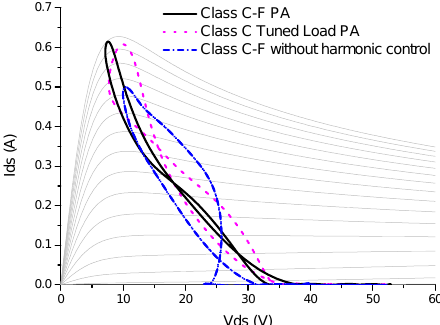
Figure 11. Comparison of simulated load lines among class-C-F PA, class-C-Tuned Load PA, and class-C-F PA without proper gate harmonic